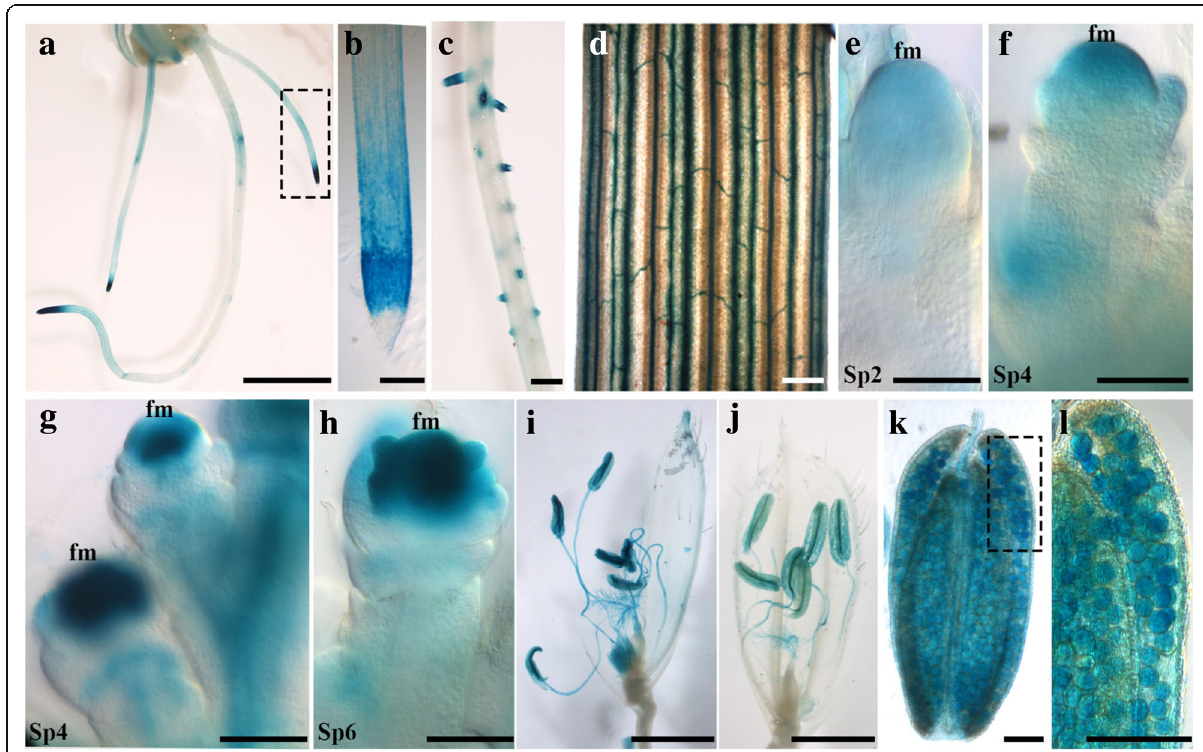
Fig. 1 Expression profiles of OsRopGEF7B in rice. a - d Detection of GUS activity in 5-d-old OsRopGEF7B pro :GUS transgenic seedlings. a The root system. b Magnification of the boxed area in A. c Lateral root and its primordia. d The third leaf. e - h Analysis of GUS activity in floral meristem and floral organ primordia of different stages in OsRopGEF7B pro :GUS plants. Flower at stage Sp2 ( e ), Sp4 ( f ), later-stage Sp4 ( g ), Sp6 ( h ), according to the definition of developmental stages by Ikeda et al. (2004). (I-L) Detection of OsRopGEF7B pro :GUS expression at anthesis stages. ( i , j ) Whole flowers. k Anther. l Magnification of the boxed area in K. fm, floral meristem. Scale bars: ( a ) 1 cm; ( b , c ) 200 μ m; ( d , e to h , k , l ) 100 μ m; ( i , j ) 1